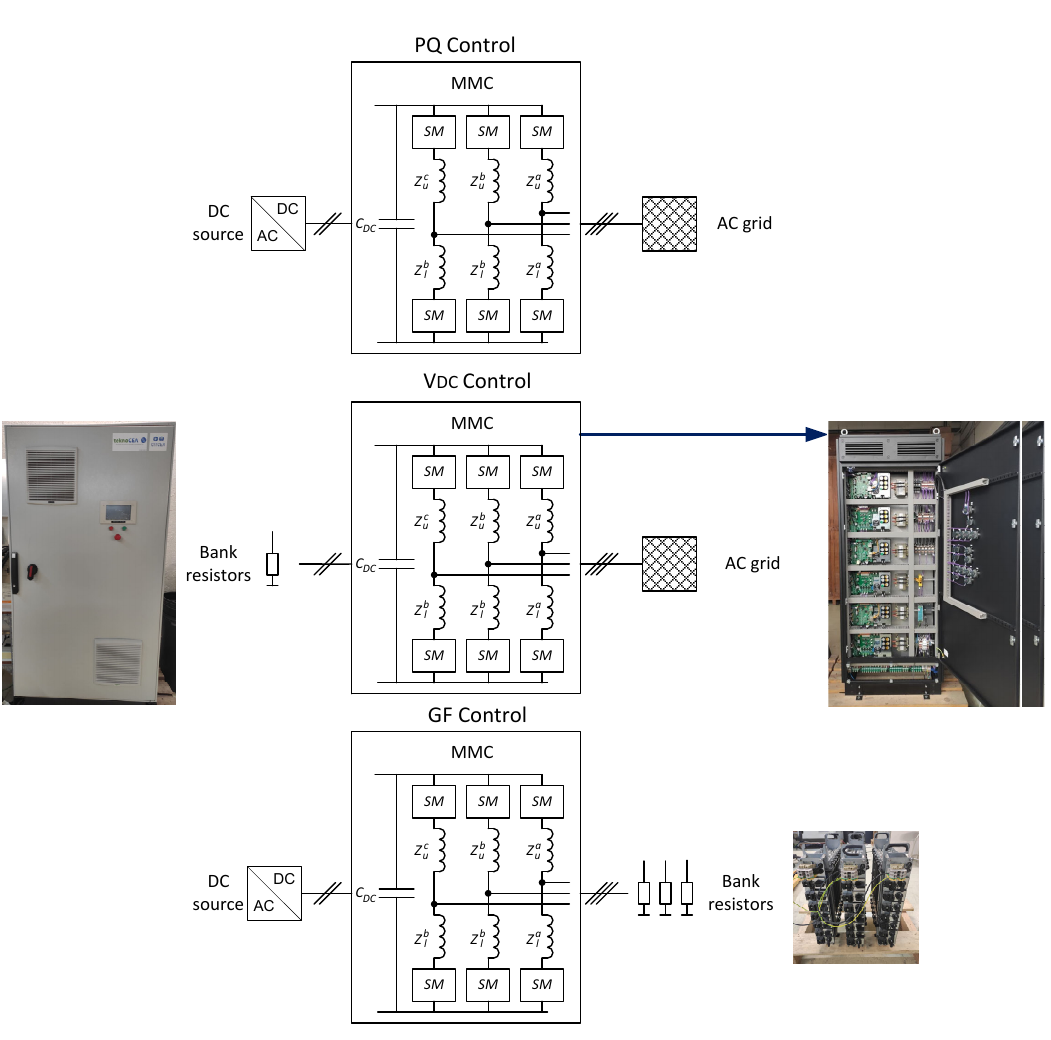
Figure 11. General setup employed for testing the